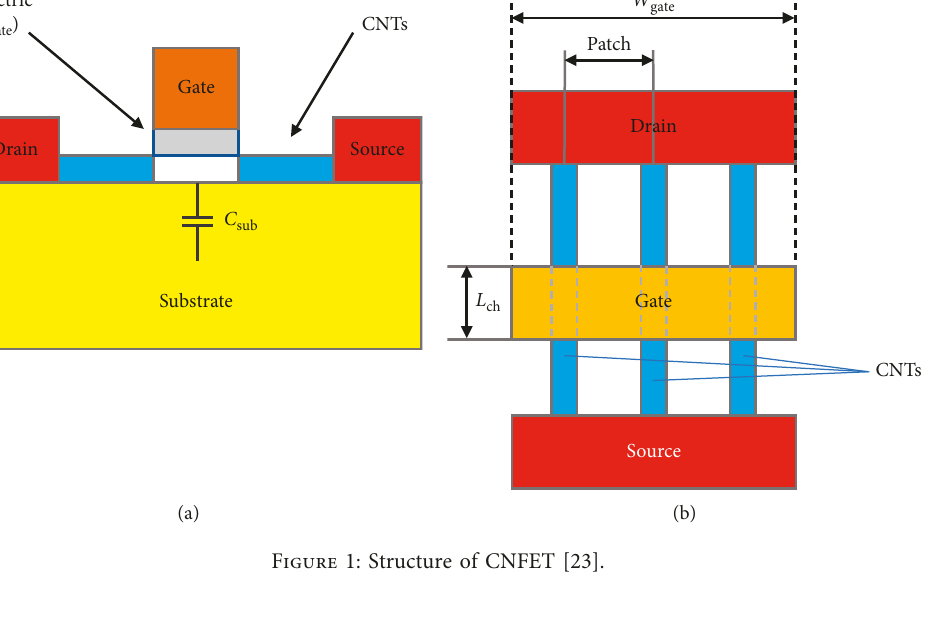
Figure 1: Structure of CNFET [23].